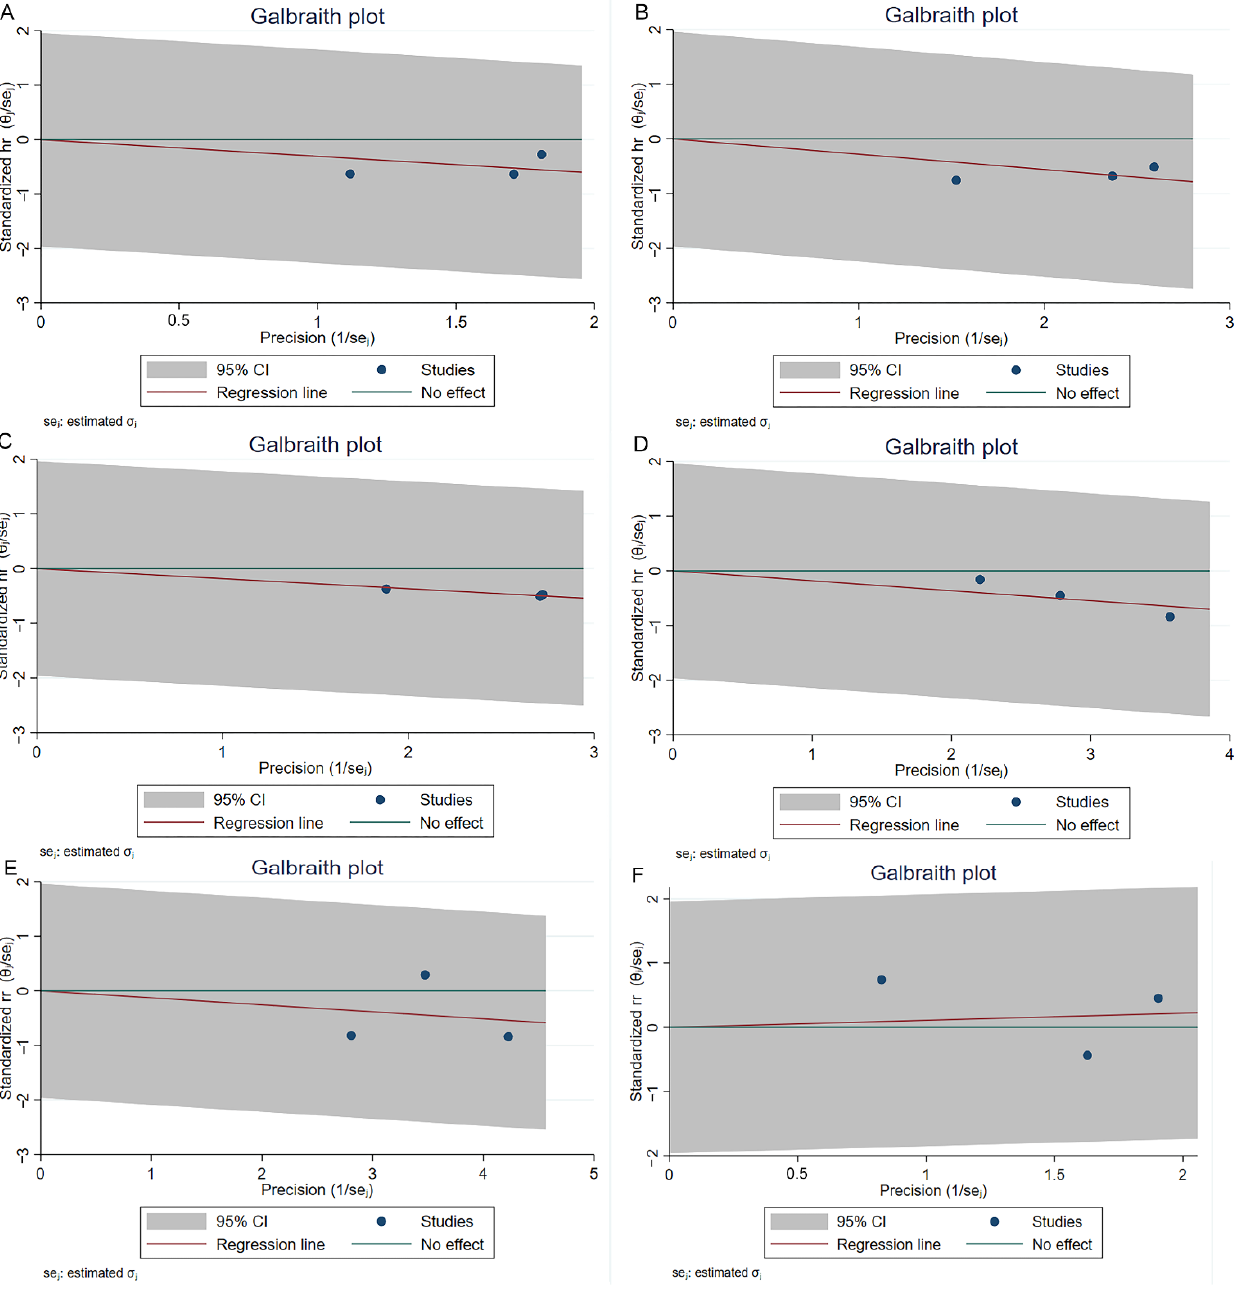
Figure 5. Galbraith plots of comparisons 1-year RFS ( A ), 2-year RFS ( B ), 3-year RFS ( C ), 5-year RFS ( D ), recurrence ( E ) and progression ( F ) between reTURB group and control group. CI: confidence interval.